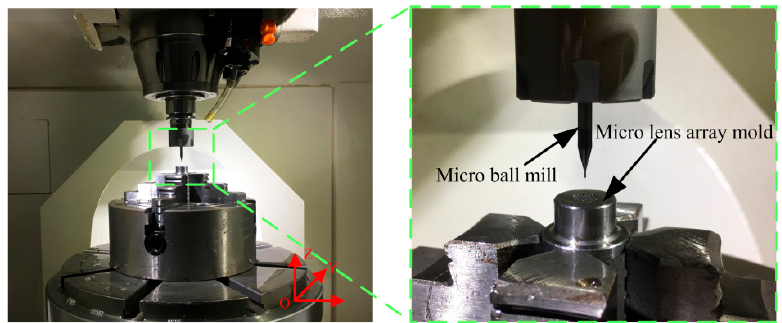
Figure 3. Micro ball end-milling experiment setup.